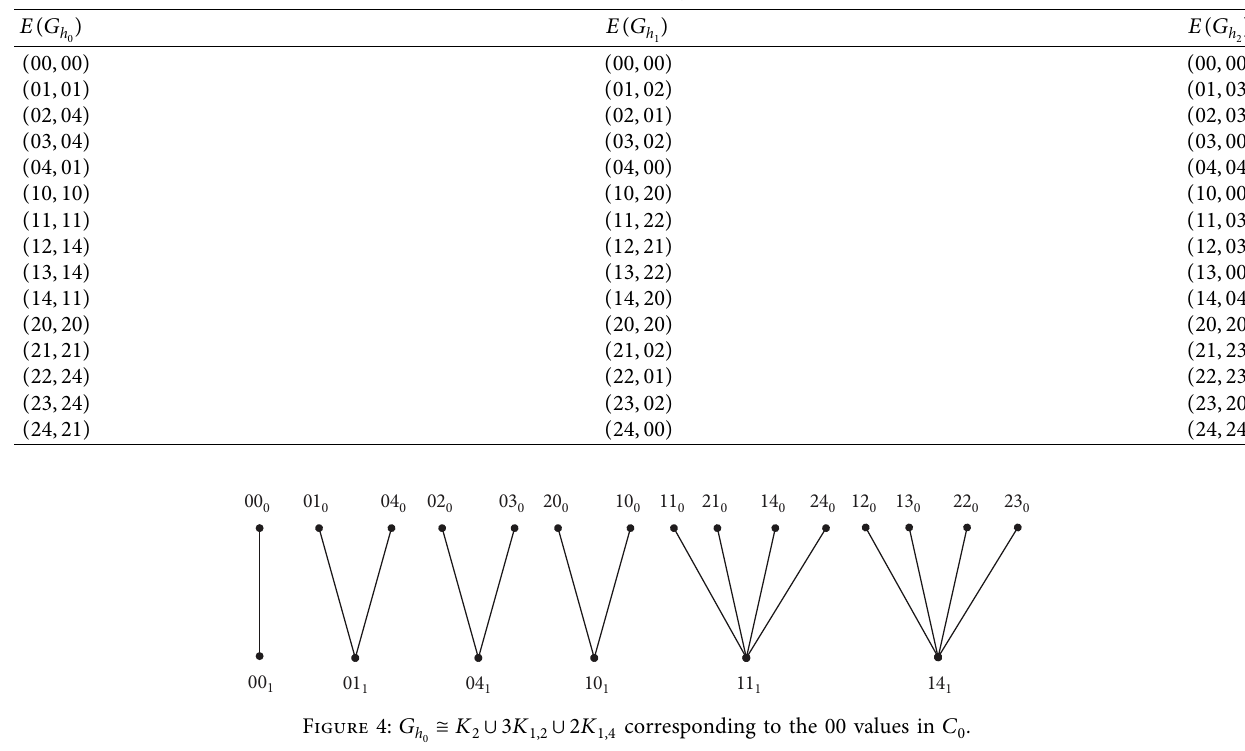
G G h 0 , h 1 , and h 2 for Example 5.